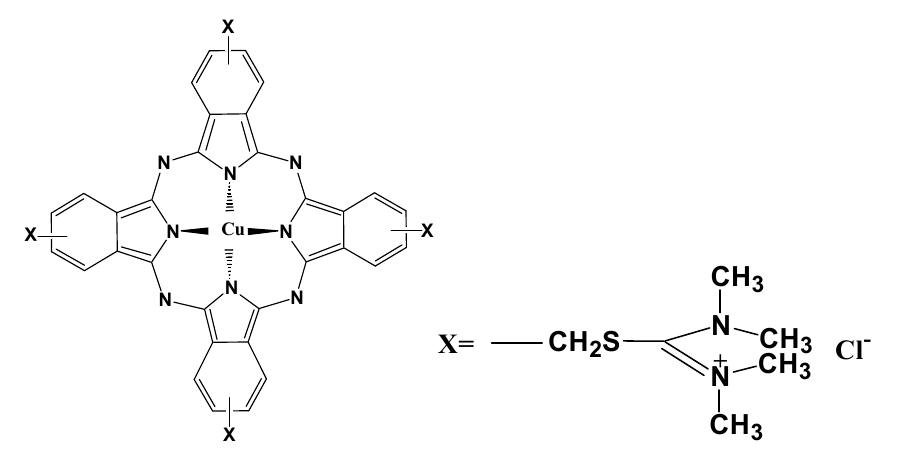
Figure 2. Molecular structure of Alcian blue 8GX.